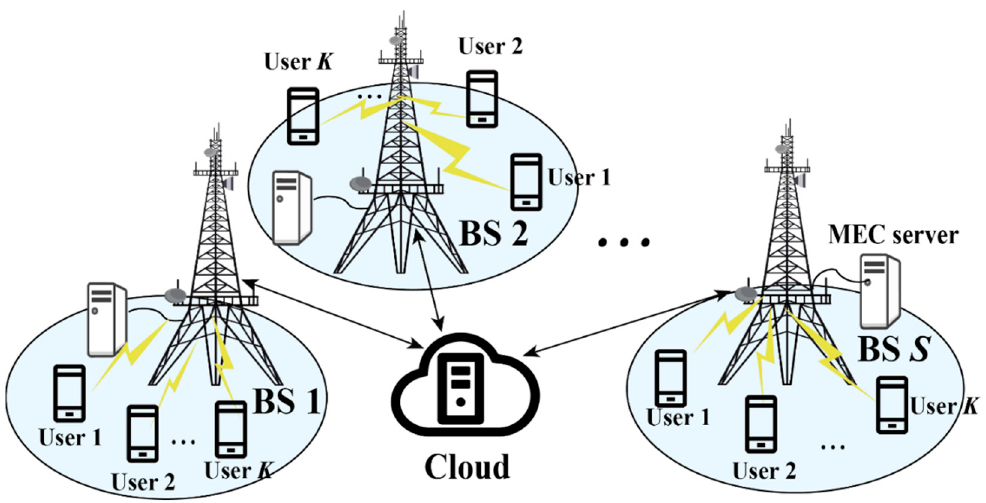
Figure 1. Basic MIMO-MEC system model.